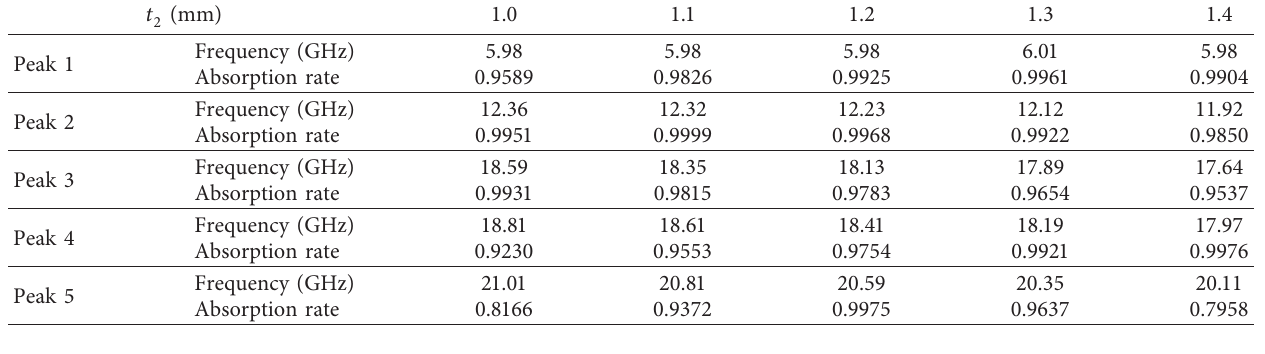
Table 4: Peaks corresponding to parameter t